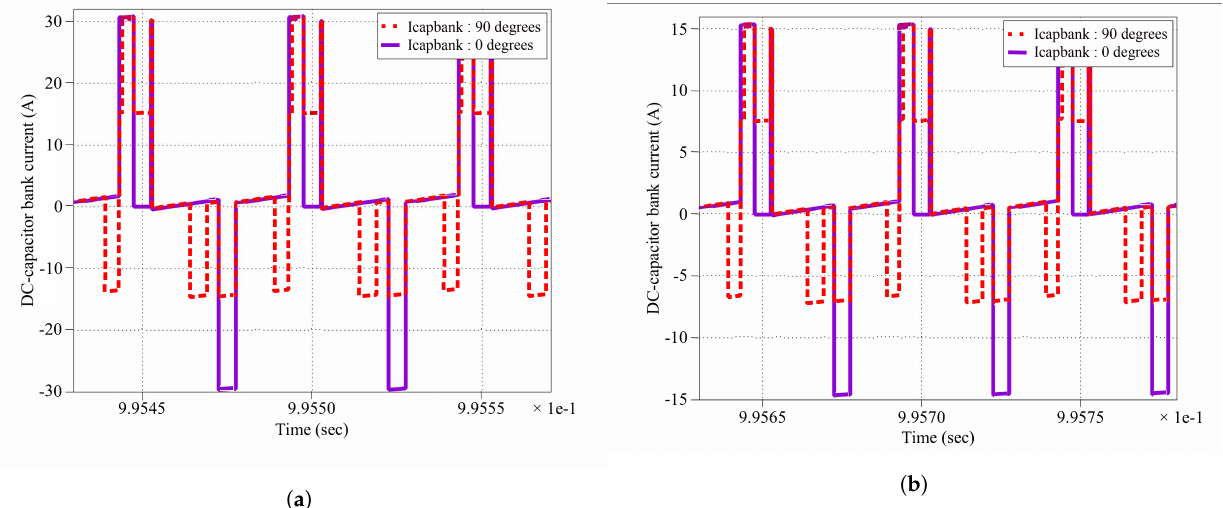
Figure 7. DC-capacitor bank current ripple reduction at θ fsw _2 = 0 ◦ (violet line), and θ fsw _2 = 90 ◦ (red dotted lines) for: ( a ) the multi-converter system with a common DC-bank, and ( b ) the multi-converter system with individual